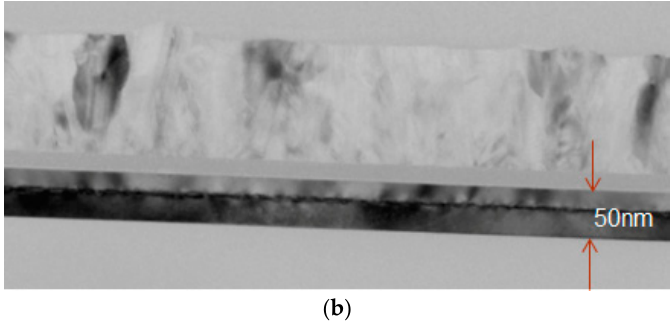
Figure 7. Transmission electron microscopic images of cross-sectional samples prepared from a bonded SOI wafer with a dislocation network in the device layer ( a ) and from the channel region of a nMOSFET ( b ). The figure shows a part of the gate complex of a MOSFET. The polycrystalline gate electrode on top of a thin gate oxide. The gate, about 50 nm thick, is characterized by a dislocation network close to the center.